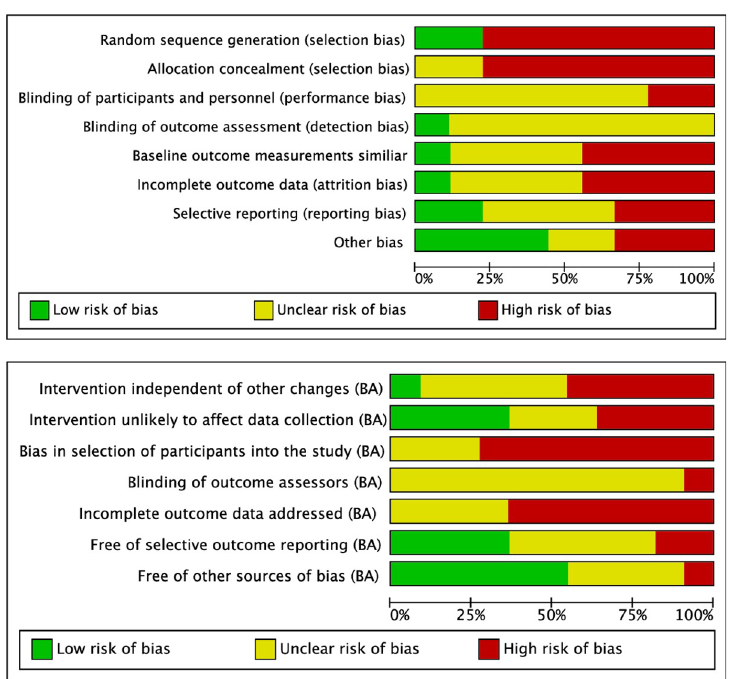
Fig 2. Risk of bias graph: Review authors’ judgements about each risk of bias item presented as percentages across all included studies. Panel A, studies with a control group. Panel B, before-after studies.